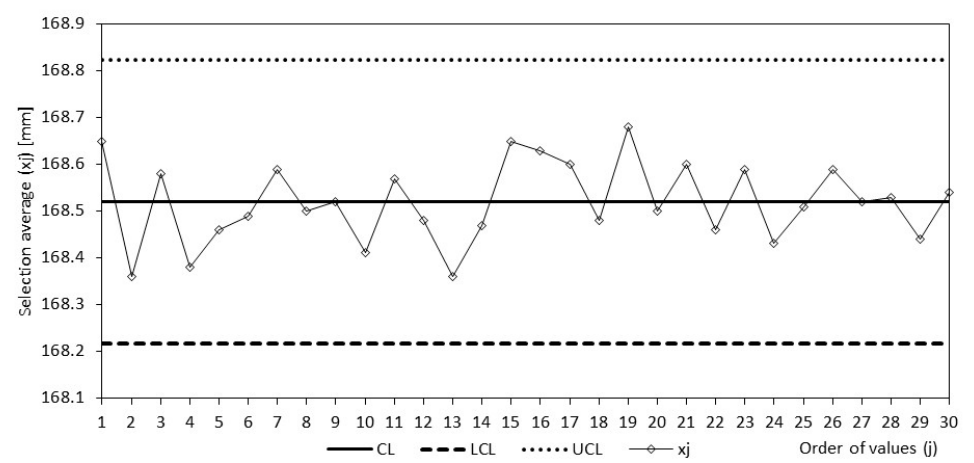
Figure 13. Shewhart control chart for individual values for the width parameter, third day.